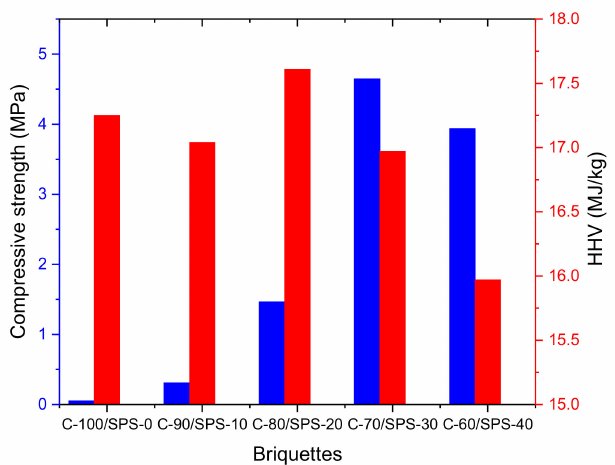
Figure 11. HHV and compressive strength of the char